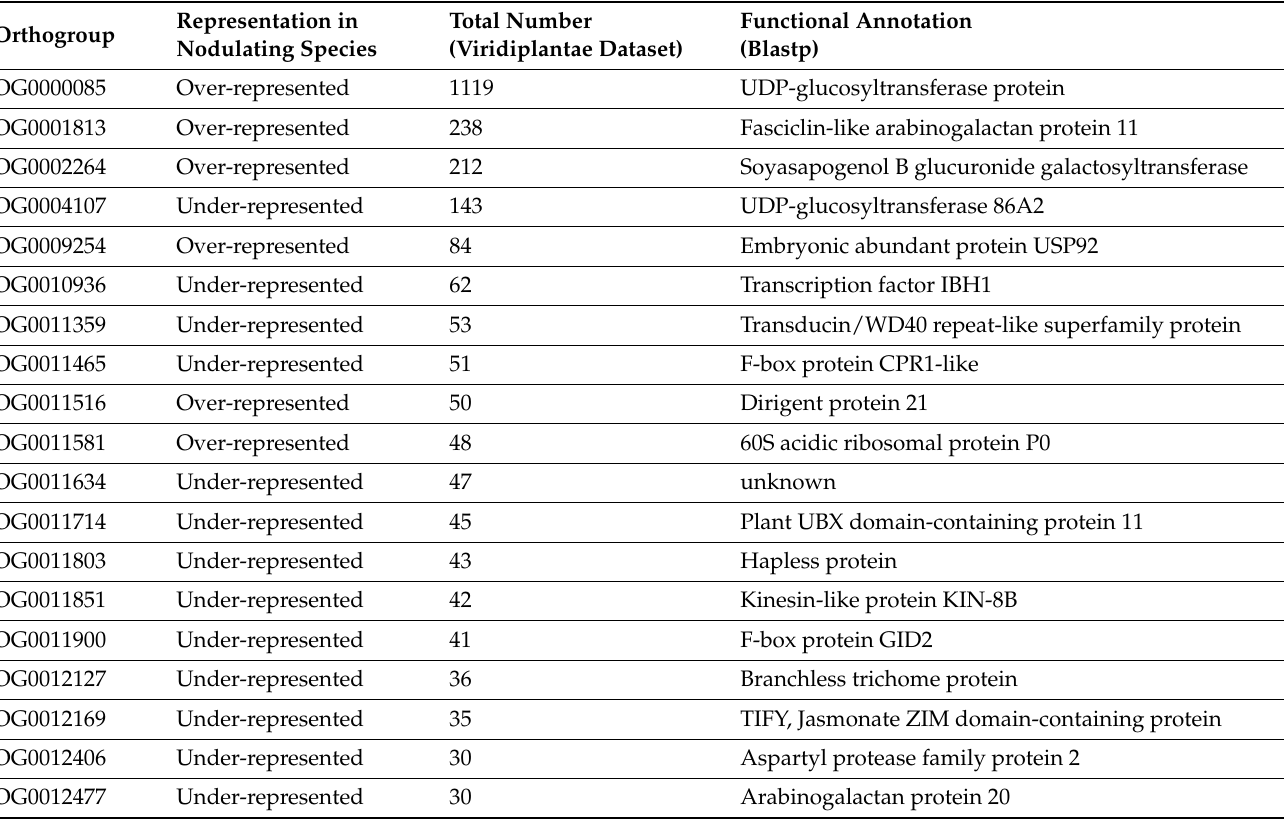
Table 5. Differentially represented orthogroups annotation and final